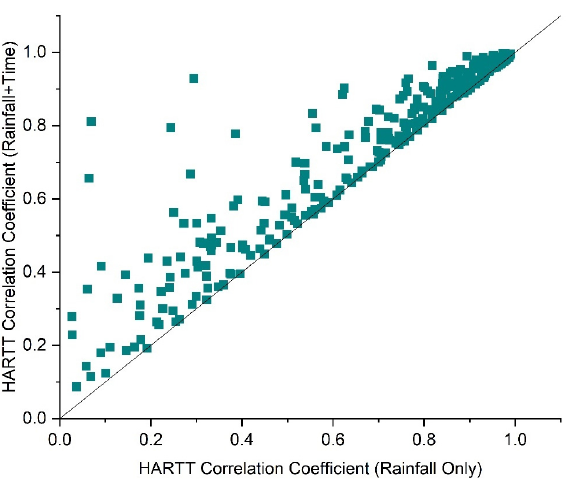
Figure 18. Scatter diagram of correlation coefficients between groundwater level and rainfall based on the rainfall only and rainfall + time HARTT models.